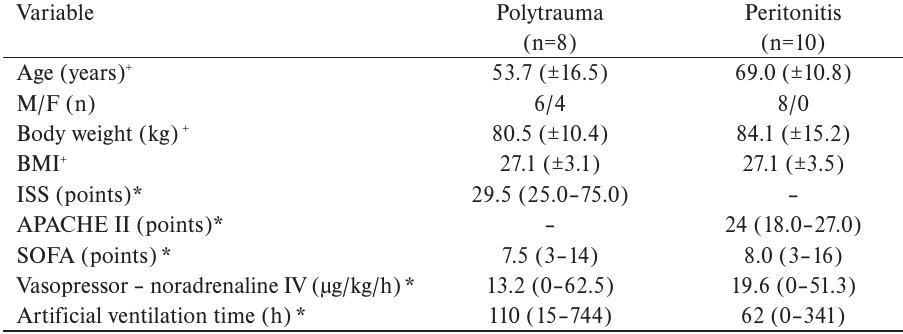
Table 1. Baseline demographic characteristics and prognostics scoring systems and systemic